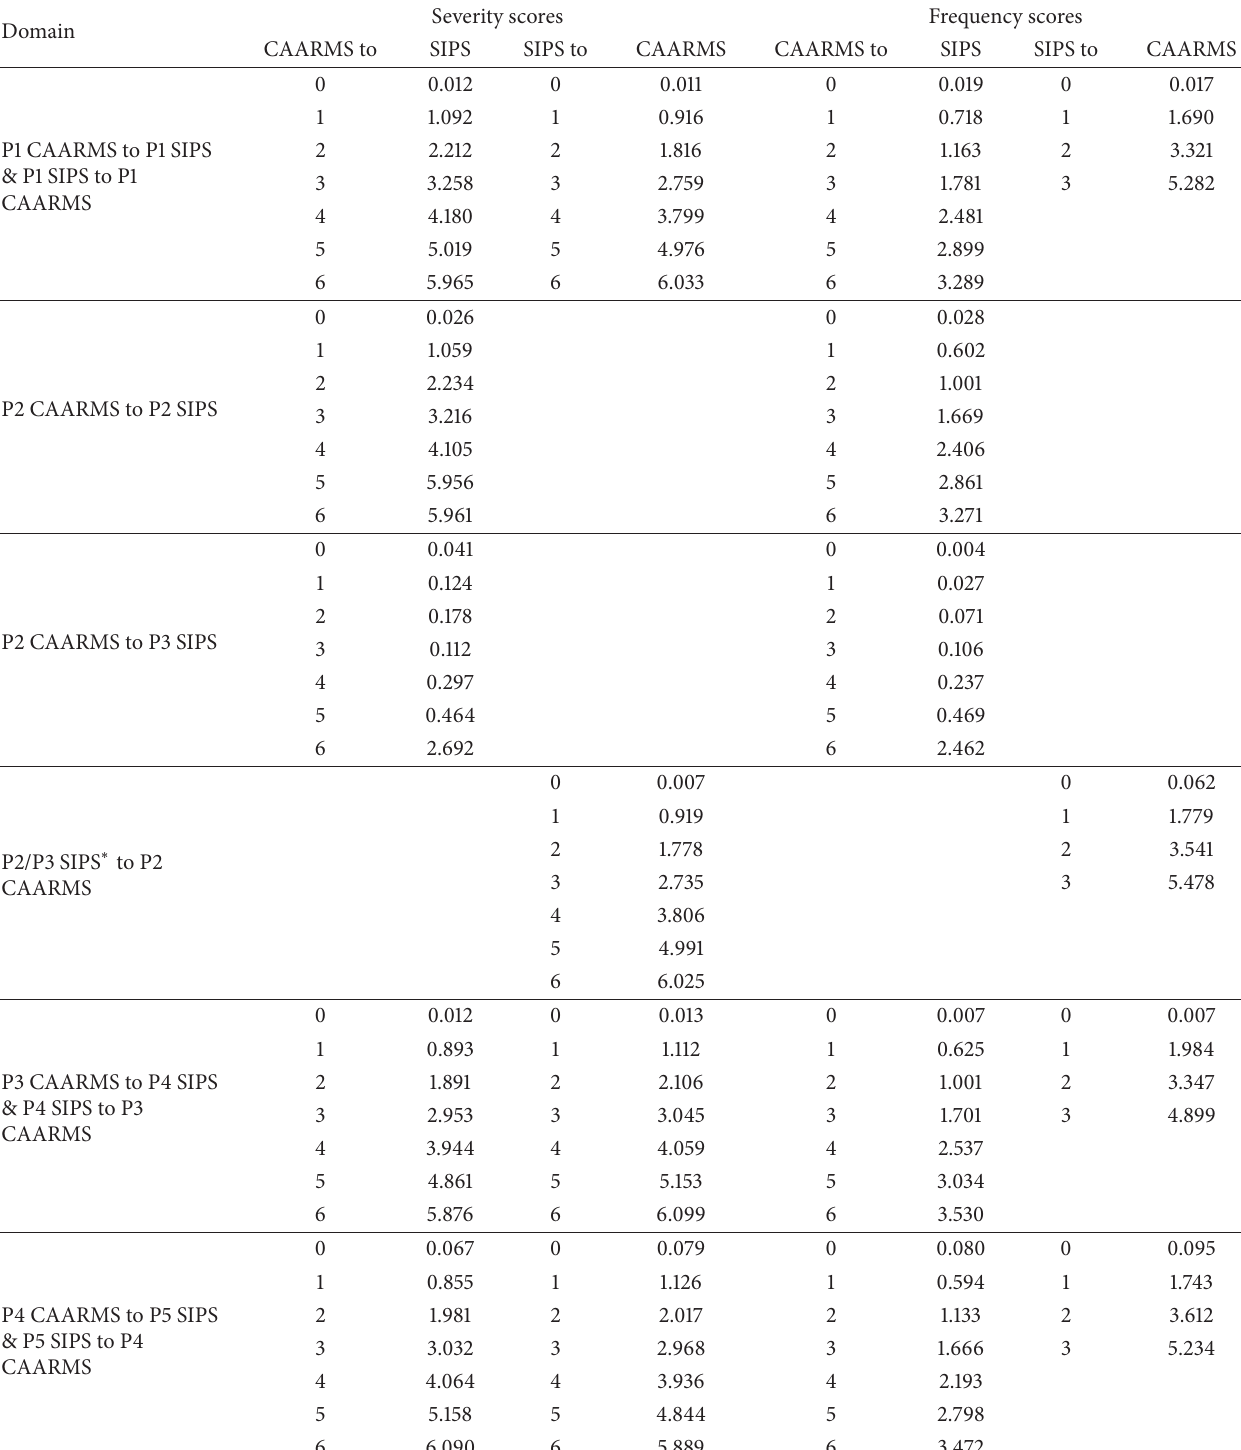
Table 4: Equipercentile-linking table comparing symptoms severity and frequency across CAARMS 12/2006 and SIPS 5.0 in the OASIS and CAMEO